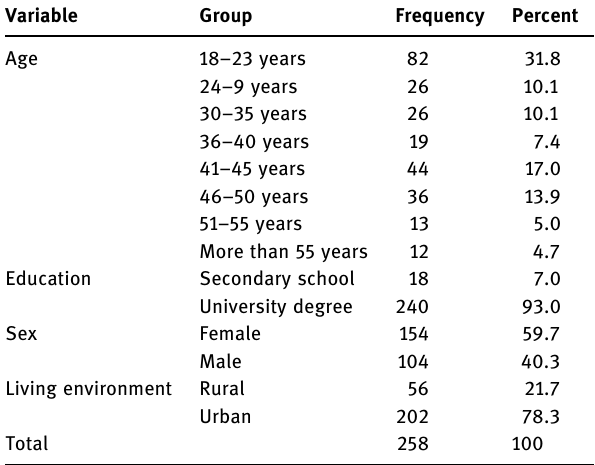
Table 1: Sociodemographic characterisation of the study sample